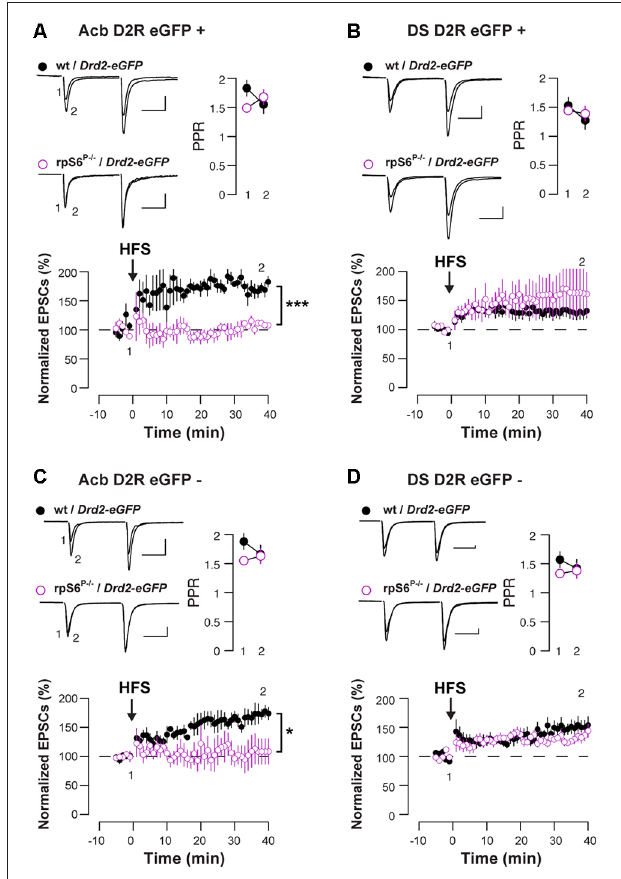
FIGURE 3 | Altered HFS-induced long-term potentiation (LTP) in Acb D1-and D2-MSNs of rpS6 P − / − mice. EPSCs were recorded from eGFP positive (D2-MSNs) (A,B) and eGFP negative (D1-MSNs) (C,D) in the Acb (A,C) or in the DS (B,D) of wt/ Drd2 -eGFP (black circles) and rpS6 P − / − / Drd2 -eGFP (magenta open circles) double transgenic mice before and after HFS-induced LTP. Graphs show normalized EPSCs as a function of time and the overlay of averaged (20 trials) traces of AMPAR EPSCs before (1) and after (2) HFS. Scale bars: 50 pA, 20 ms. Symbols represent average of six trials. ∗ p < 0.05; ∗∗∗ p < 0.001 by Student’s t -test ( n and p values in Supplementary Table